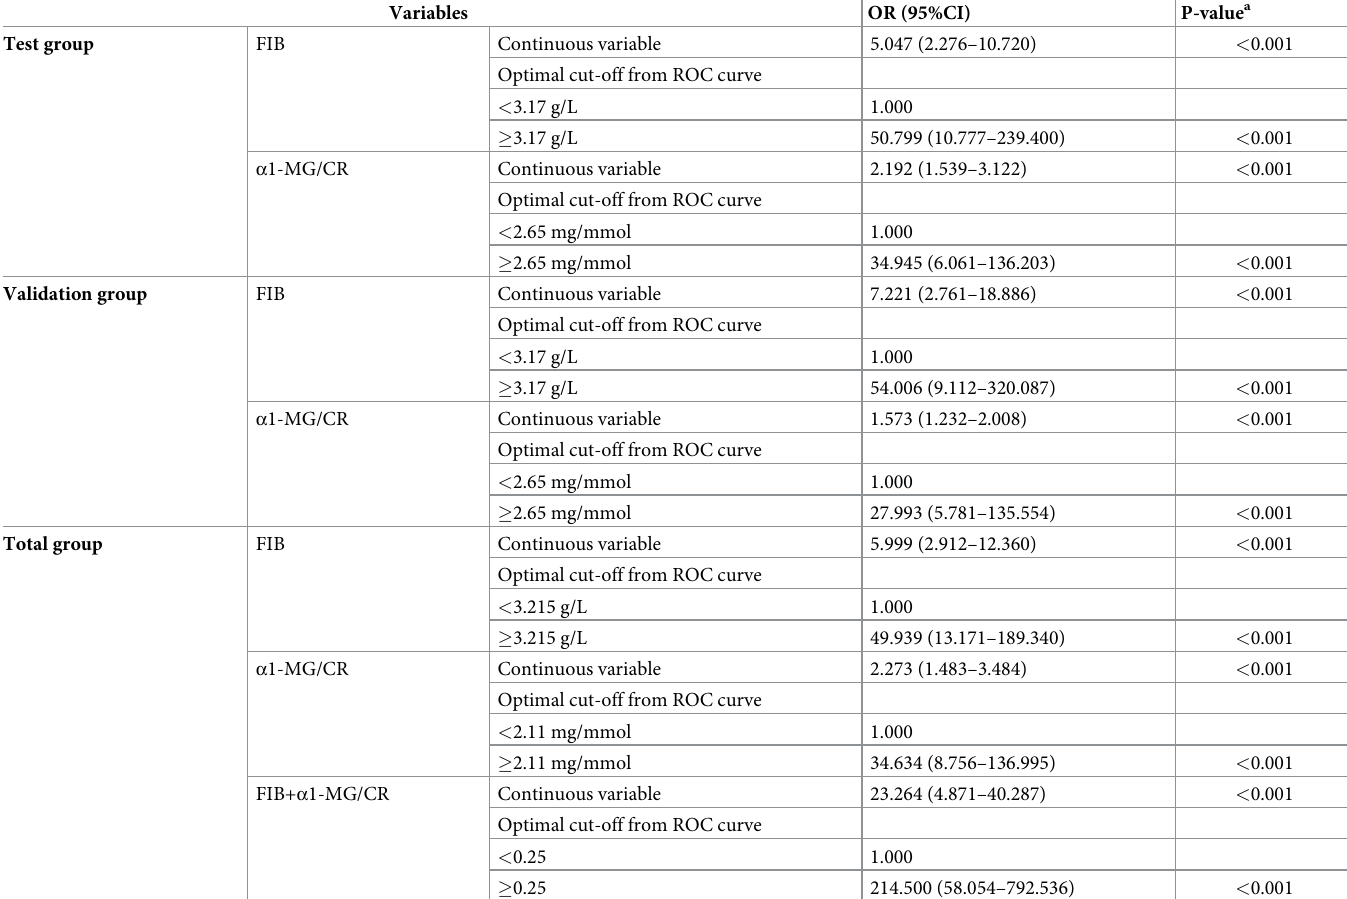
Table 3. Adjusted multivariate analysis of joint FIB and a1-MG/CR for DKD